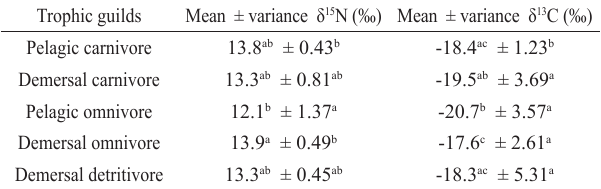
Table 2. δ 13 C and δ 15 N signatures and their variances among